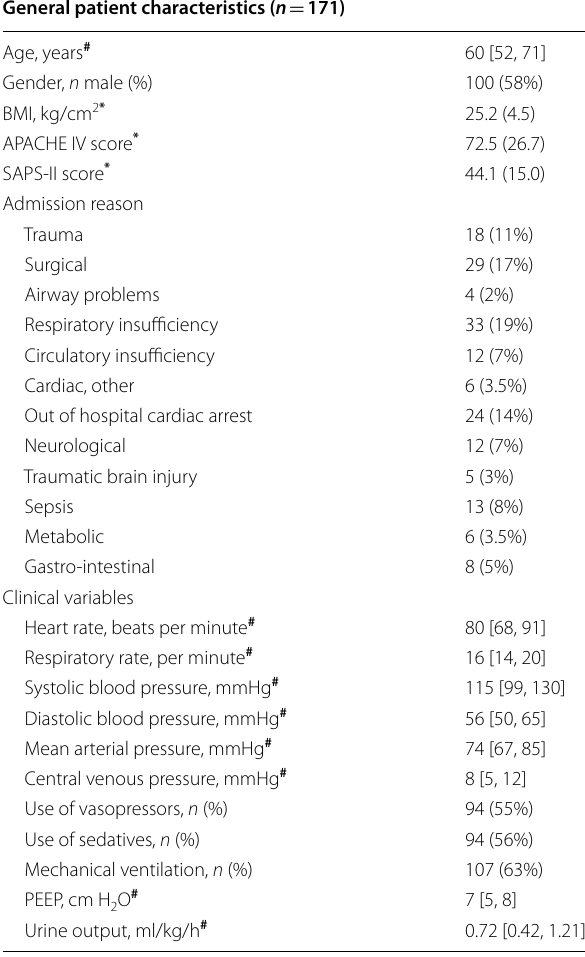
Table 1 Baseline characteristics of included patients